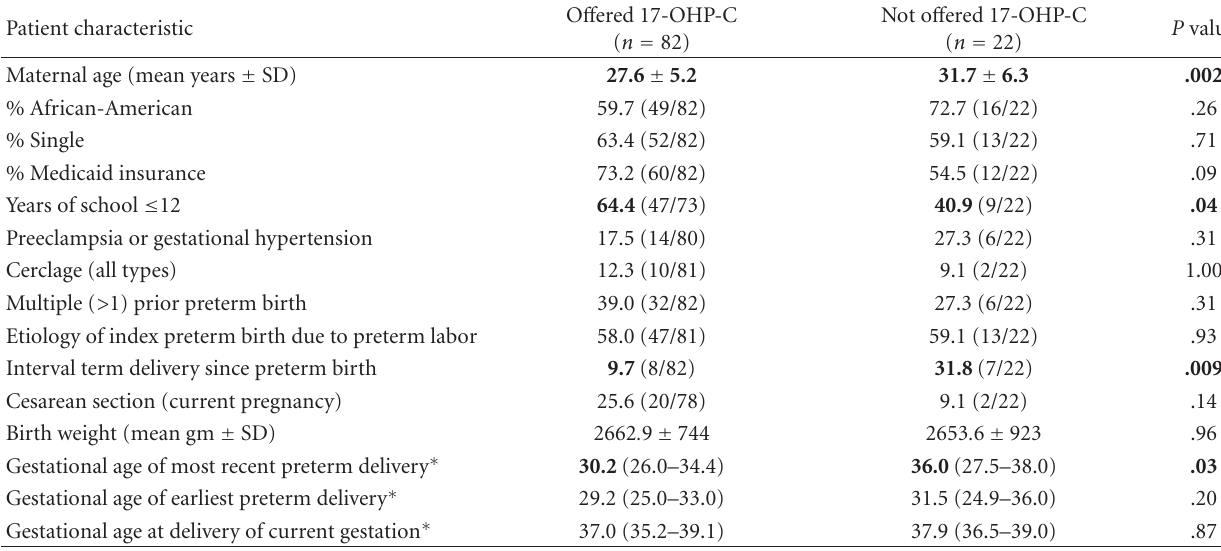
Table 1: Demographic and clinical characteristics of subjects eligible for 17- Hydroxyprogesterone caproate (17-OHP-C). Patient characteristic